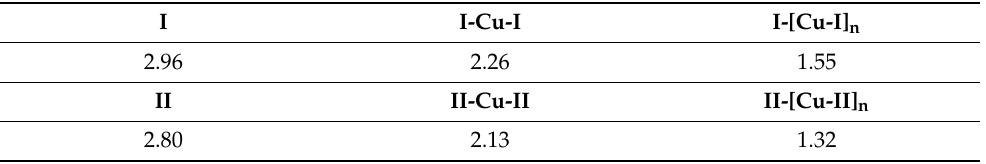
Table 7. Diffusion coefficients (D × 10 − 10 , m 2 s − 1 ) of the complexes I and II and the products of their interaction with Cu 2+ at the 1:1 and 1:5 concentration ratios of the reagents.